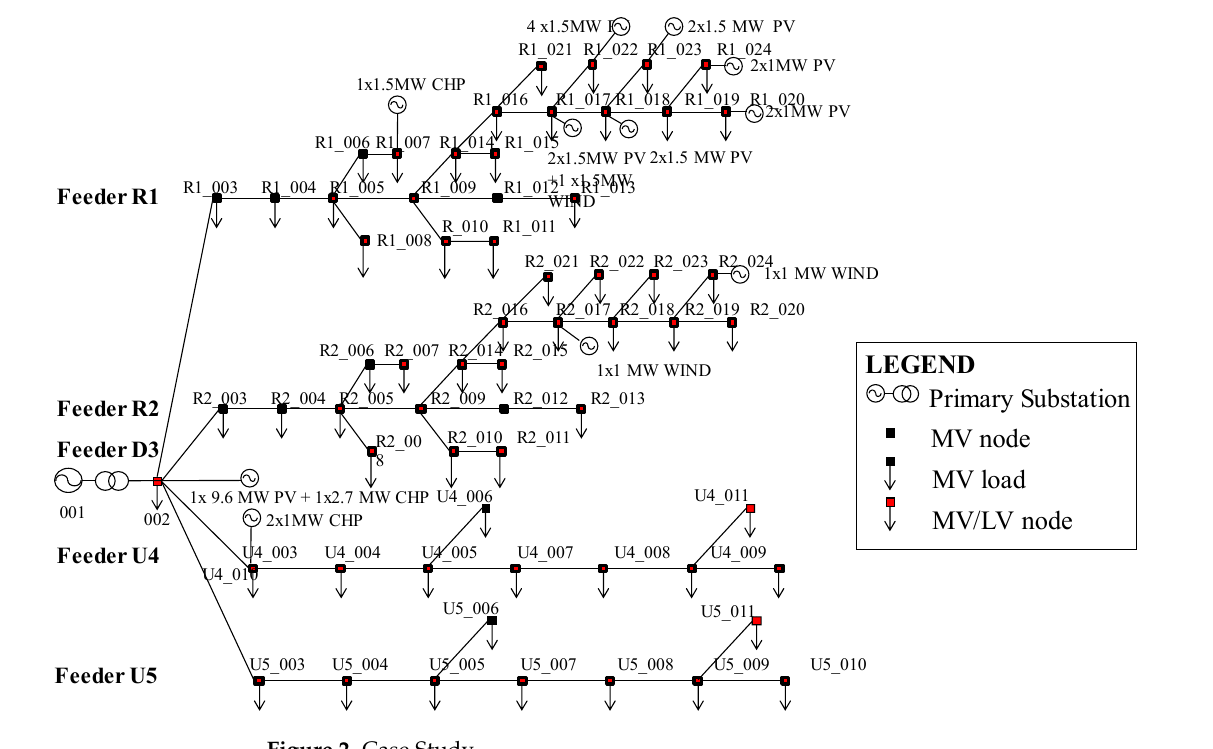
Figure 2. Case Study.